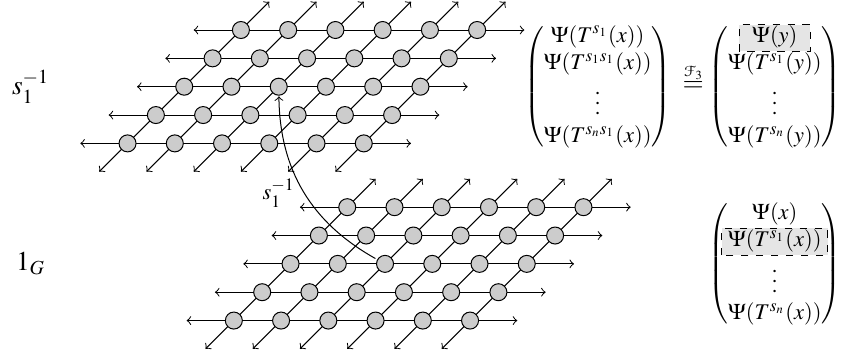
Figure 3: The set F 3 links the different ( H 1 × H 2 ) -cosets by forcing that in all configurations as above then Ψ ( y ) = Ψ ( T s 1 ( x ))